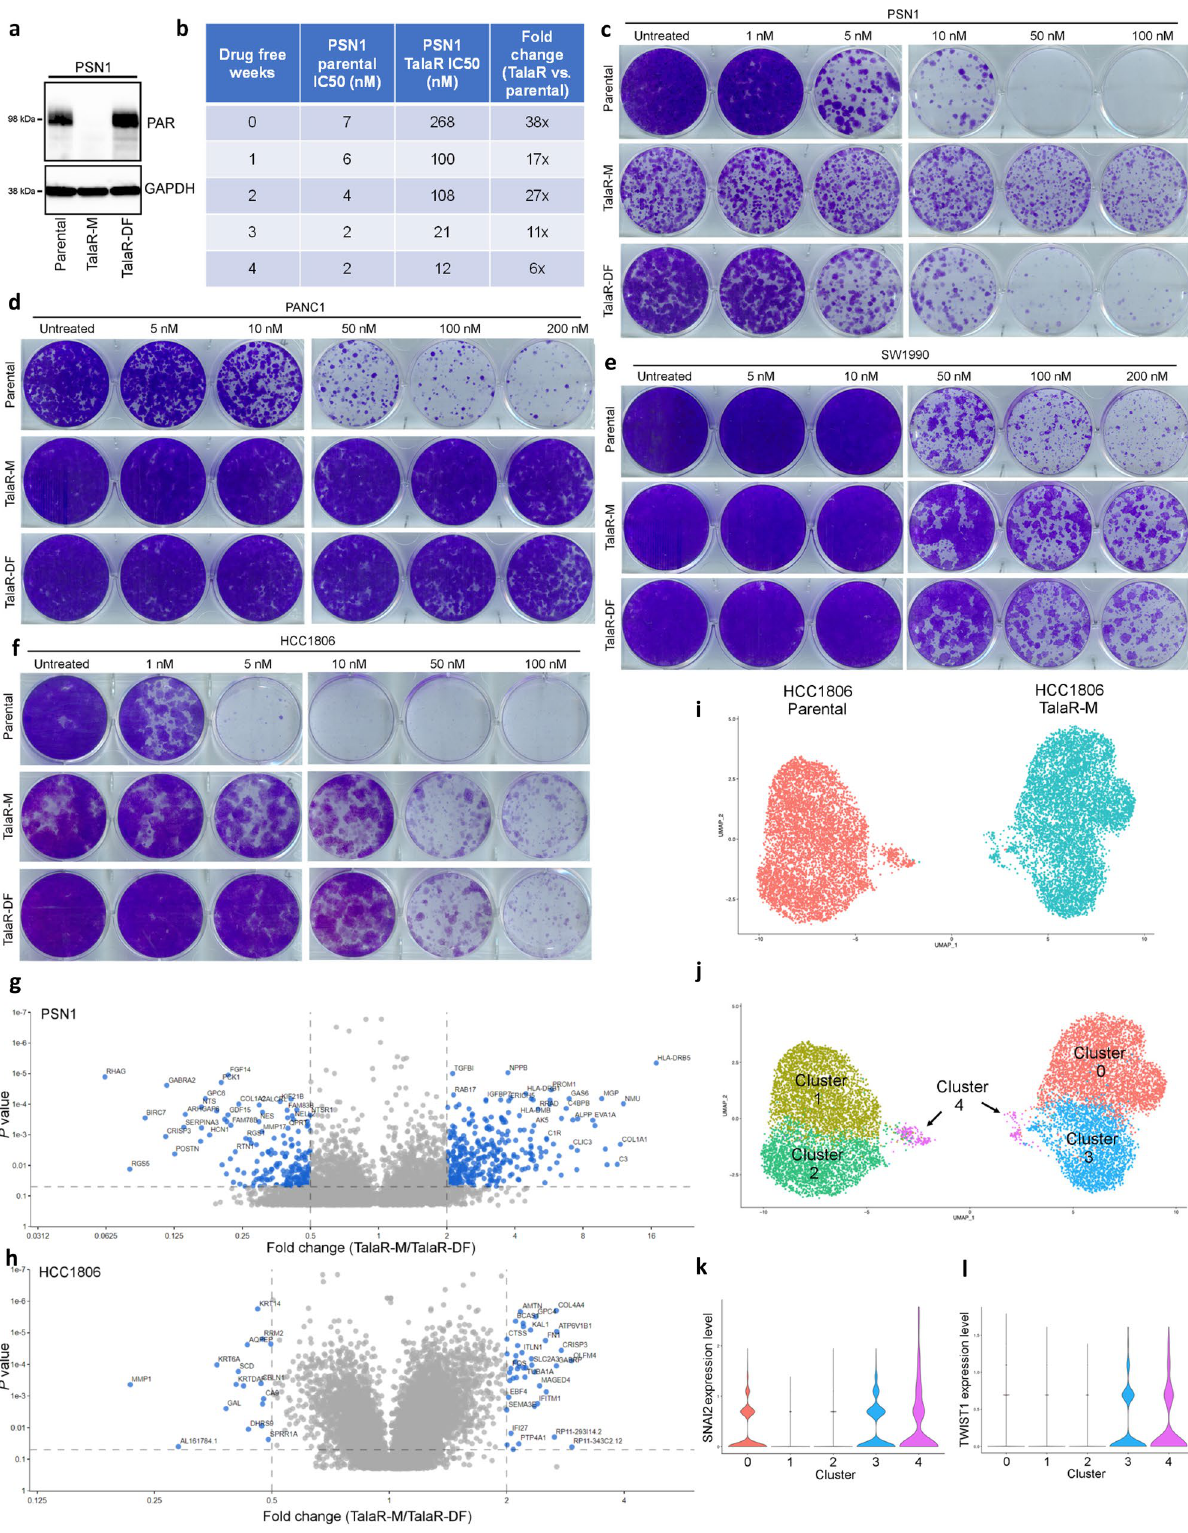
Figure 2. Cell line-dependent reversibility of acquired Talazoparib resistance. ( a ) Immunoblot showing PAR level of PSN1 parental cells, TalaR cells maintained in media with Talazoparib (TalaR-M) and TalaR cells cultured in drug-free media for 4 weeks (TalaR-DF). ( b ) Talazoparib IC 50 chart showing reversibility of acquired resistance in PSN1 cells over 4 weeks after drug withdrawal. ( c – f ) Clonogenic assay showing Talazoparib sensitivity of parental and acquired resistant cells in PSN1, PANC1, SW1990 and HCC1806 cells which were maintained in drug media (Tala-M) and in drug free media for 4 weeks (Tala-DF). ( g , h ) Volcano plots showing differentially expressed genes between TalaR-M and TalaR-DF in PSN1 and HCC1806 cells. ( i , j ) UMAP representations of HCC1806 parental and resistant subpools, colored by cell line ( i ) or cluster identity ( j ). ( k , l ) Violin plots of SNAI2 ( k ) and TWIST1 ( l ) gene expression profile across subpopulation clusters shown in ( j